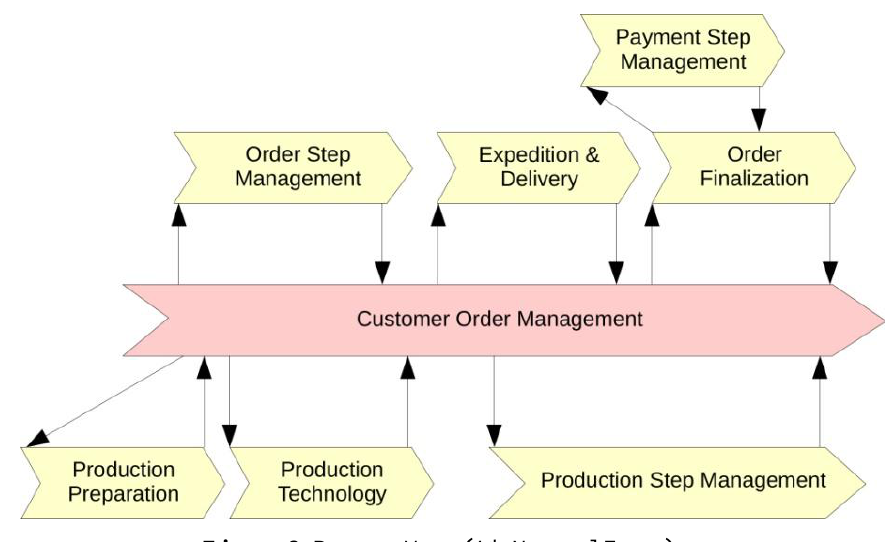
Figure 8. Process Map (4th Normal